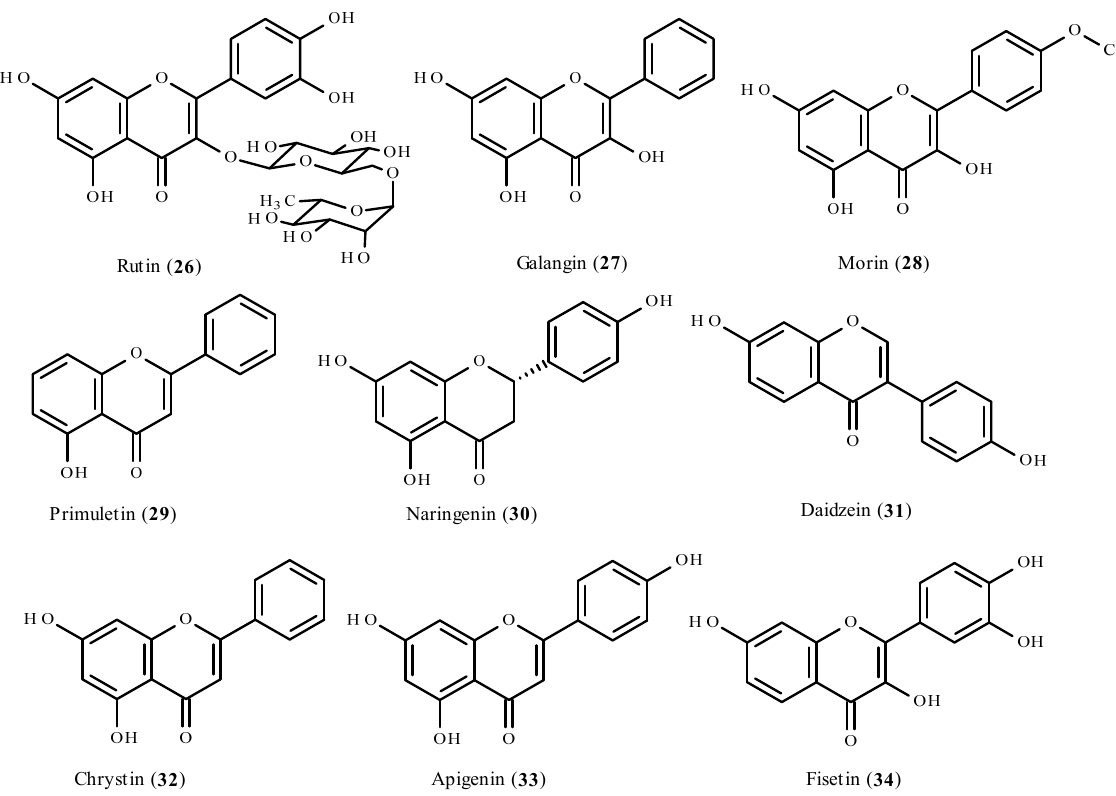
Figure 4. Structures of compounds 26 – 34 .